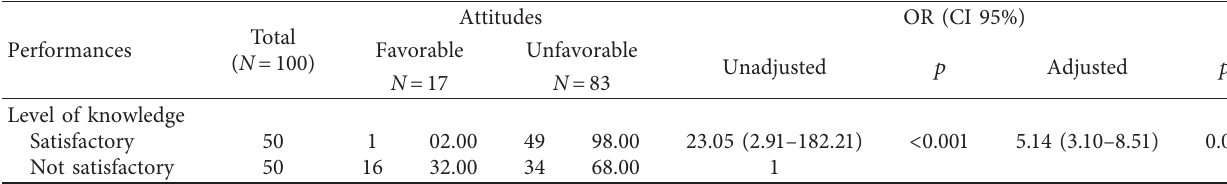
Table 4: Relation between knowledge and attitudes of healthcare workers.